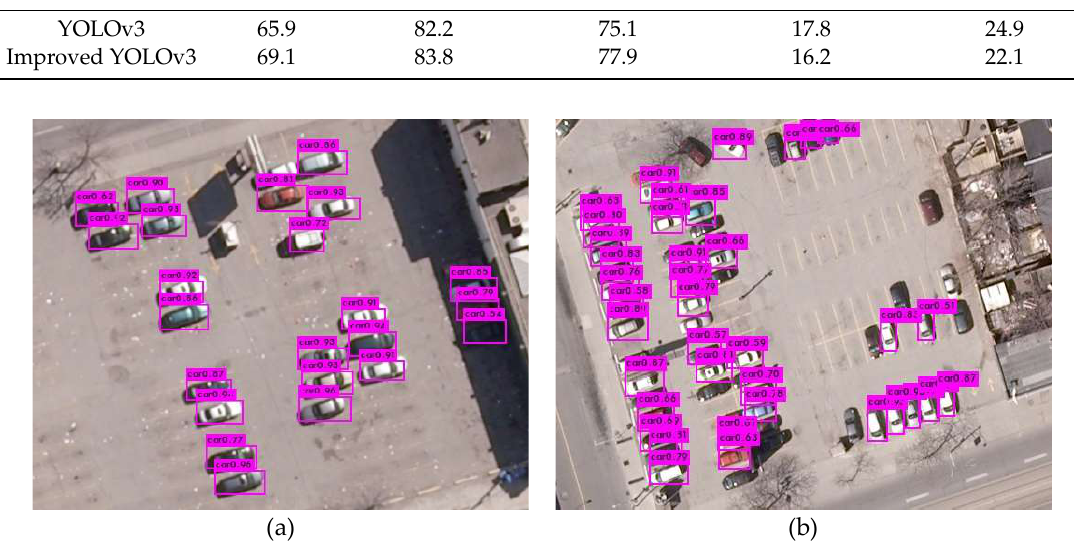
Figure 11. Detection examples for the COWC dataset: ( a ) Example 1; ( b ) Example 2.